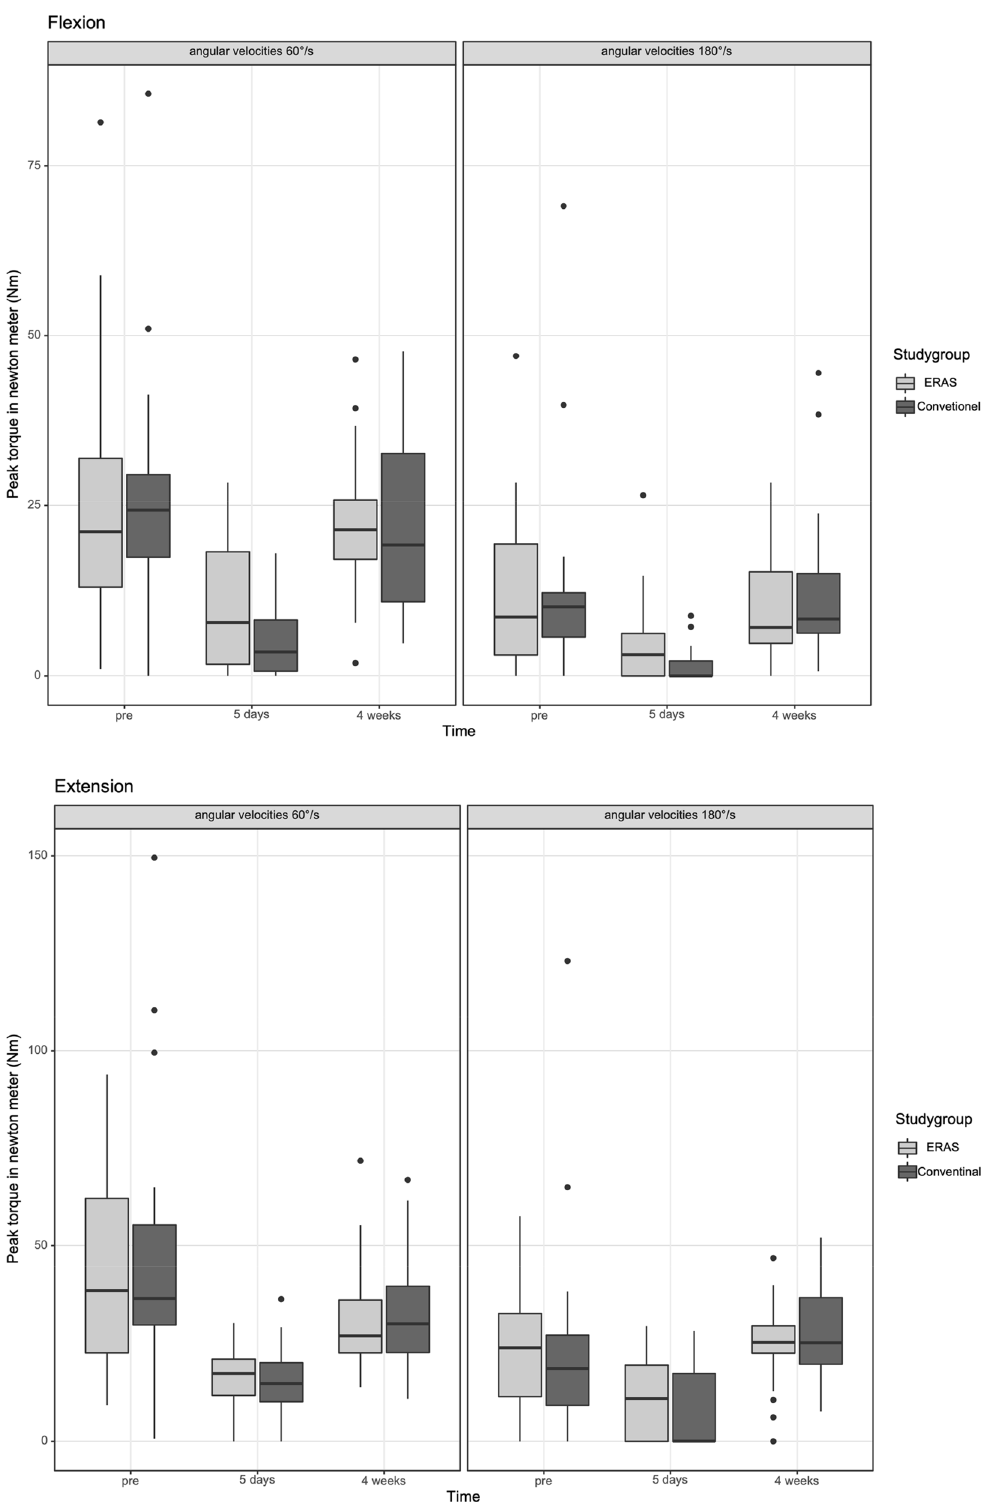
Fig. 2 a and b The flexion ( a ) and extension ( b ) peak torque of the operated knee achieved for the two angular velocities measured (180°/s and 60°/s). The x-axis corresponds to the enhanced recovery after surgery (ERAS) to conventional setup preoperative, 5 days after surgery and 4 weeks postoperative. The y-axis corresponds to the peak t torque in newton meter